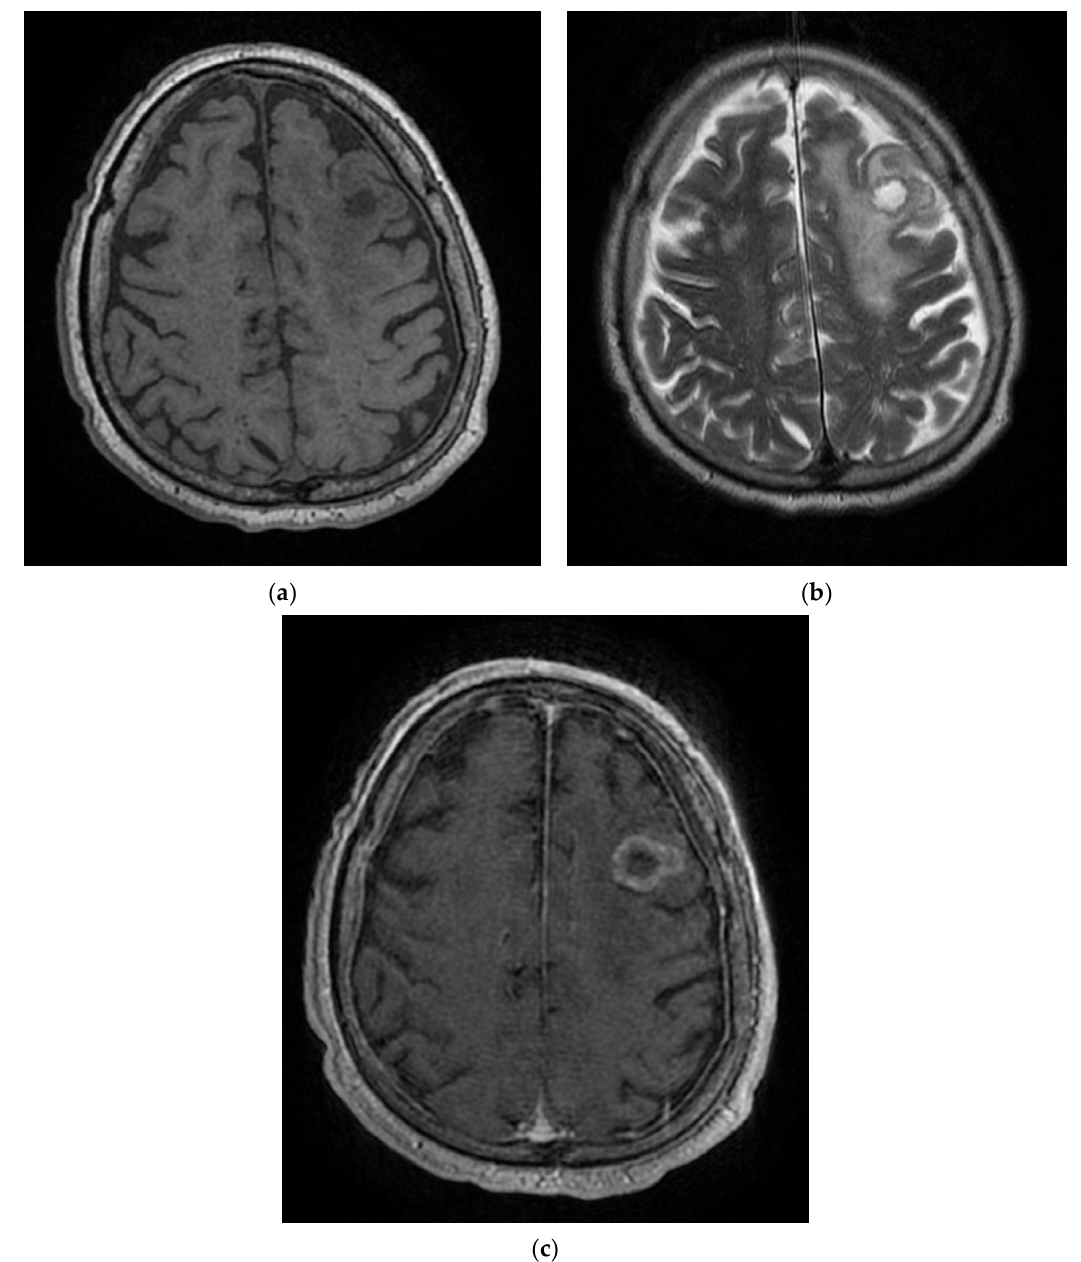
Figure 7. MRI T1 ( a ), T2 ( b ), and T1 sequence with contrast injection in the Case 7 patient ( c ) show solid-cyst mass ( a , b ) with ring-shaped peripheral gadophilia ( c ) and extended perilesional edema ( b ), disposed in the middle-left subcortical area. These pathological images are suggestive of a left-frontal expansive lesion, most likely meaning a secondary determination.